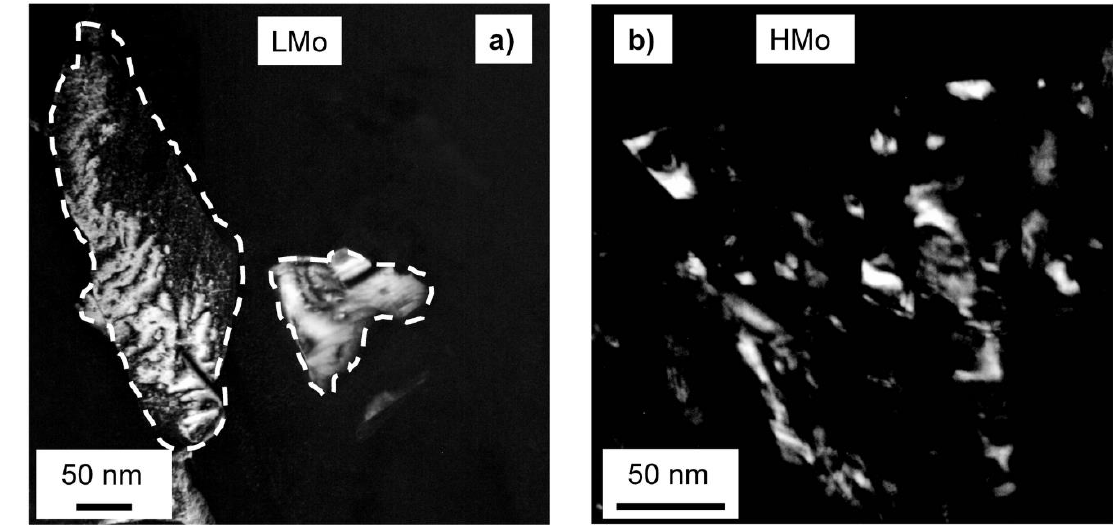
Figure 1. Dark-field transmission electron microscope (TEM) micrographs showing the grains in films with ( a ) low Mo content (LMo) and ( b ) high Mo content (HMo). In ( a ) the grains are bordered by white dashed curves for a better visibility.